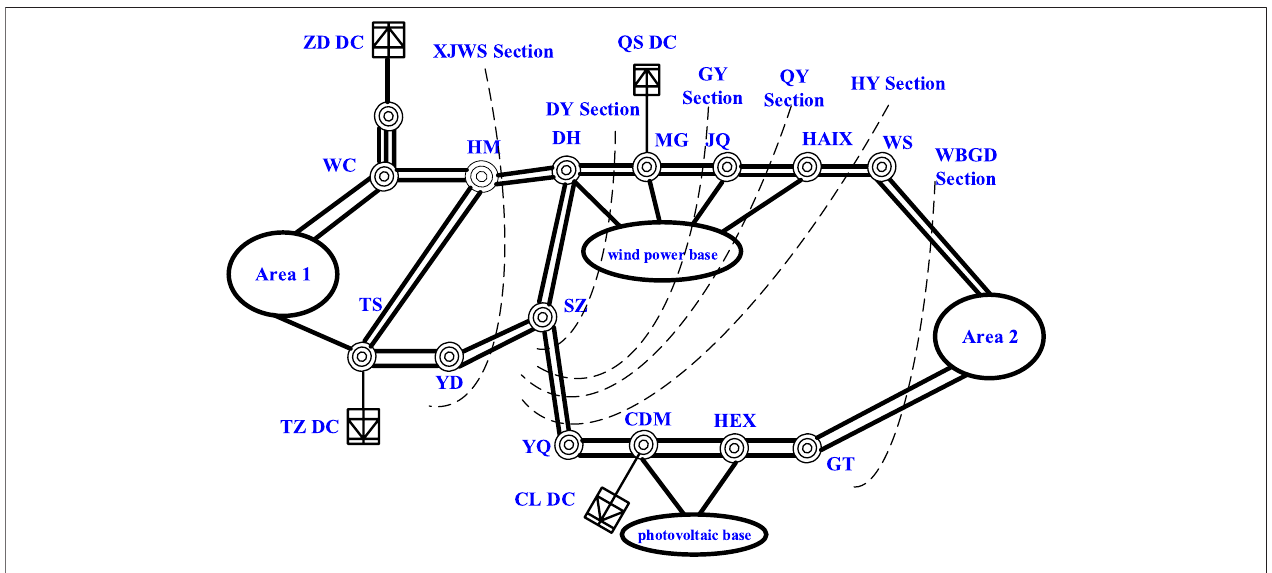
FIGURE 3 | The structure diagram of the networked channel between Xinjiang district and Northwest main